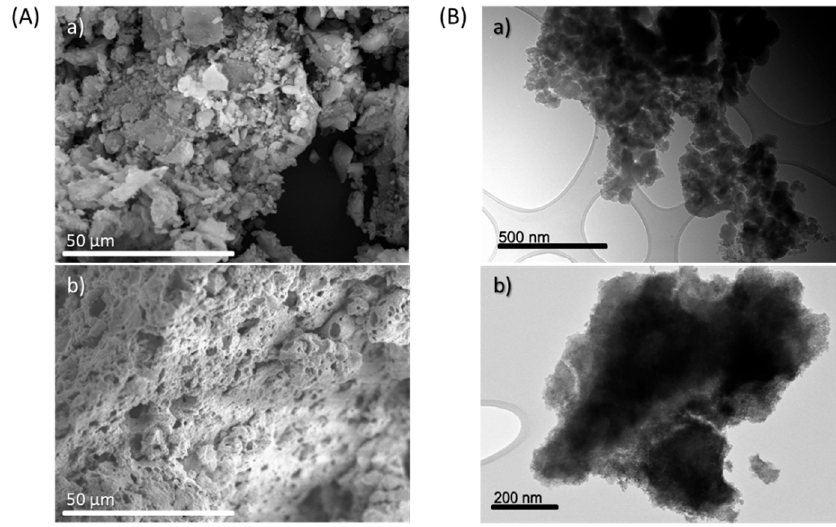
Figure 2. ( A ) SEM and ( B ) TEM images of (a) RH-Silica and (b) α -Fe 2 O 3 /RH-Silica.